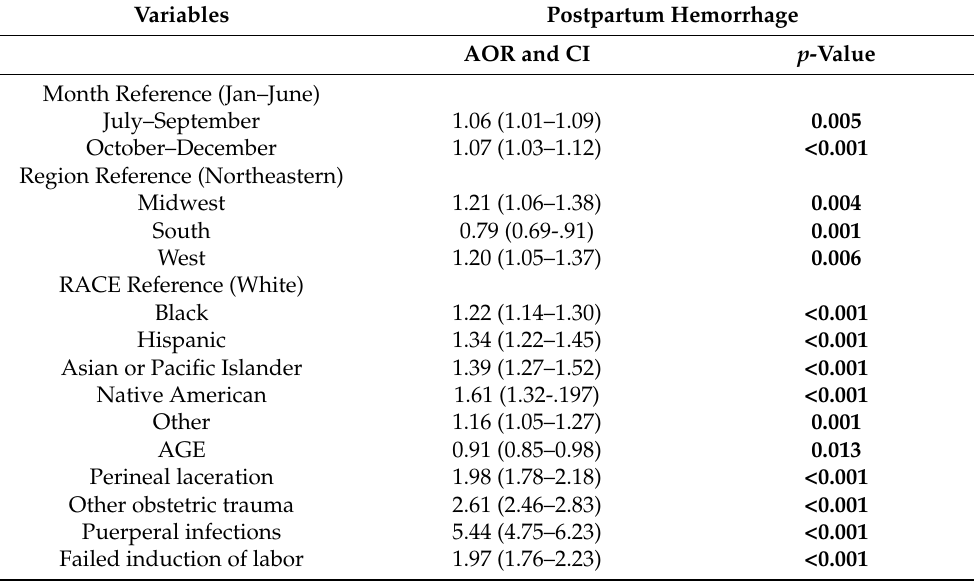
Table 2. Logistic Regression of Postpartum Hemorrhage: Adjusting for PPH Risk Factors.